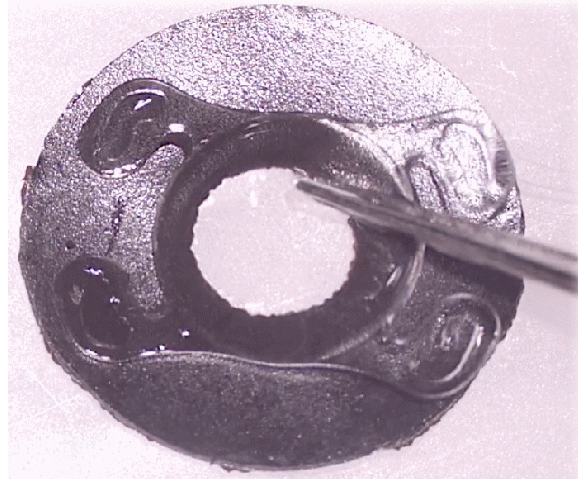
Figure 2: The Akreos ® IOL-ArtificialIriscomplex